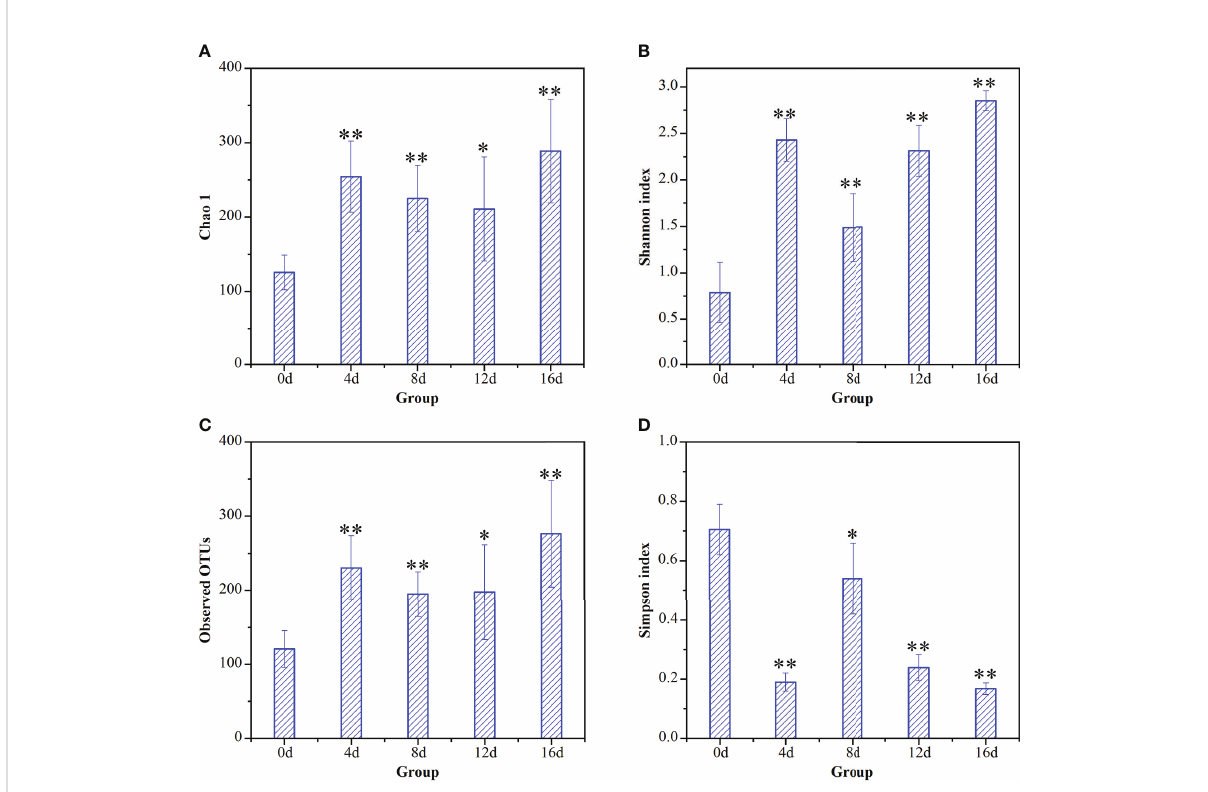
FIGURE 2 Temporal dynamic changes of short-term exercise on alpha-diversity of gut micro fl ora communities of this hybrid species. Effects of exercise on (A) Chao1 index, (B) Shannon index for species diversity, (C) observed OTUs, and (D) Simpson index in intestinal microbial of hybrid fi sh. * P ≤ 0.05, ** P ≤ 0.01. Data were provided as mean ± SD.